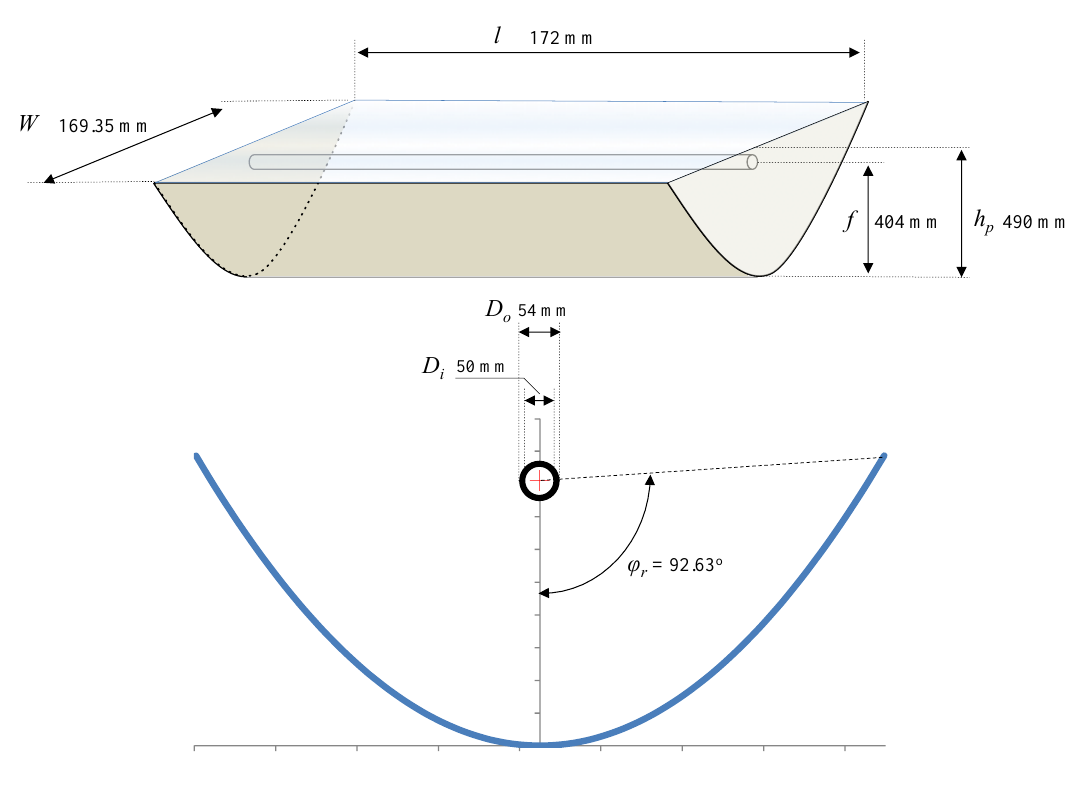
Figure 4. Schematic diagram of the parabolic concentrator. Table 1. The PTC geometrical parameters.